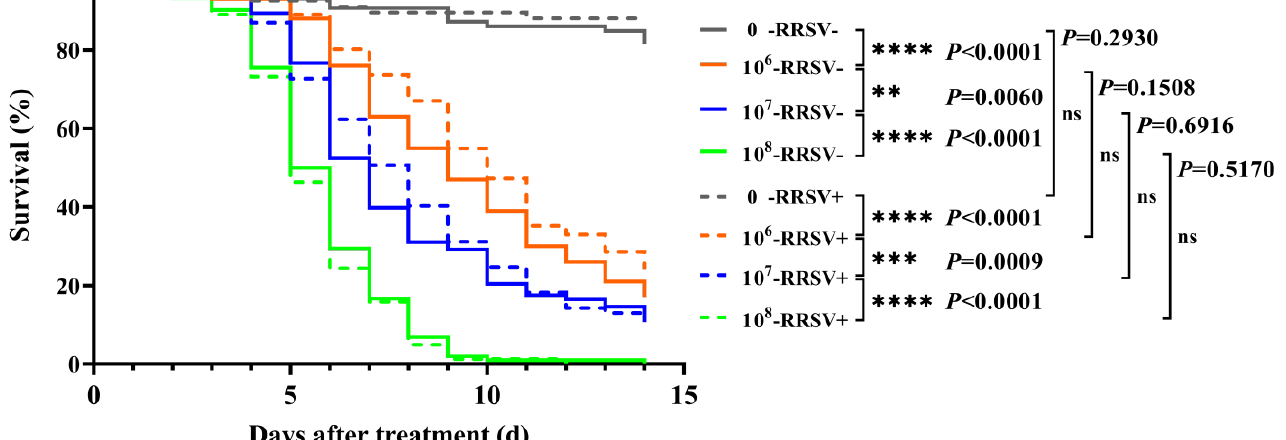
Figure 1. Survival curves of BPH showing RRSV-meditated lethal effects of Metarhizium anisopliae YTTR against BPH. Data are mean ± SEM (n = 30), and significant differences were represented by definite P value and asterisk (** p < 0.01; *** p < 0.001; **** p < 0.0001) (Logrank test). In fact, 0, 10 6 , 10 7 , and 10 8 are the various concentrations of M. anisopliae YTTR at 0, 1 × 10 6 , 1 × 10 7 , and 1 × 10 8 spores/mL, respectively. RRSV – and RRSV+ represent RRSV-free or RRSV-carrying BPH respec- tively.